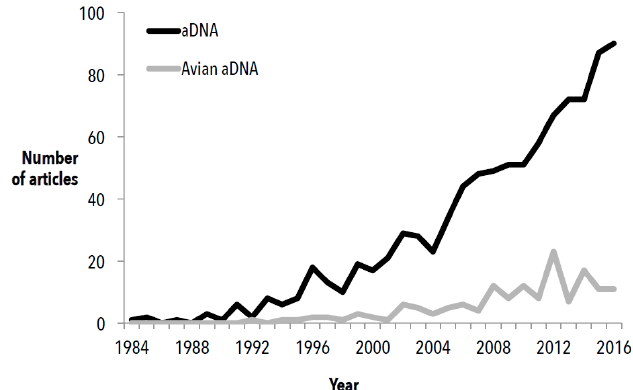
Figure 1. The number of Web of Science articles found containing the terms “(palaeo* DNA) or (paleo* DNA) or (archaeol* DNA) or (archeol* DNA) or (ancient DNA) or aDNA or (extinct* DNA) or (historic* DNA) or palaeogenom* or paleogenom* or archaeogenom* or archeogenom*” in the title (Black), alongside aDNA studies that were ornithological in nature (Table S1) (Grey), each year since the inception of the field (audit accurate as of June 2017). Studies in both categories were manually examined for relevance.